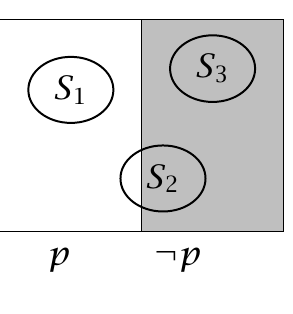
Figure 3 φ -verifiers and φ